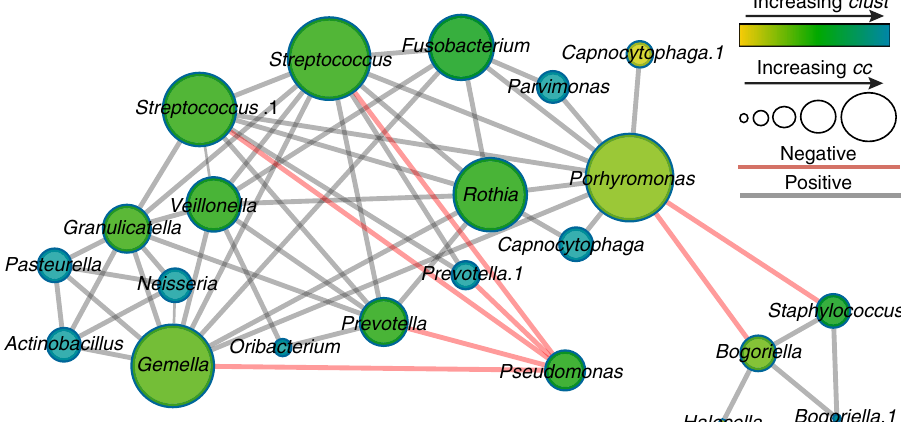
Fig. 1 Co-occurrence network inferred from the SparCC algorithm applied to 16S rRNA gene data of 126 CF sputum samples. Co-occurrence and anti-occurrence of taxa is denoted with grey lines and red lines, respectively. Nodes are sized by their degree closeness centrality (cc) and colored by increasing clustering coef fi cient (increasing from olive to green to blue). The major taxa clustering strongly support the CAM hypothesis, stating that the CF community splits into two differently pathogenic subgroups: Attack Community members such as Streptococcus , Veillonella and Porphyromonas , and the Climax Community dominated by Pseudomonas and